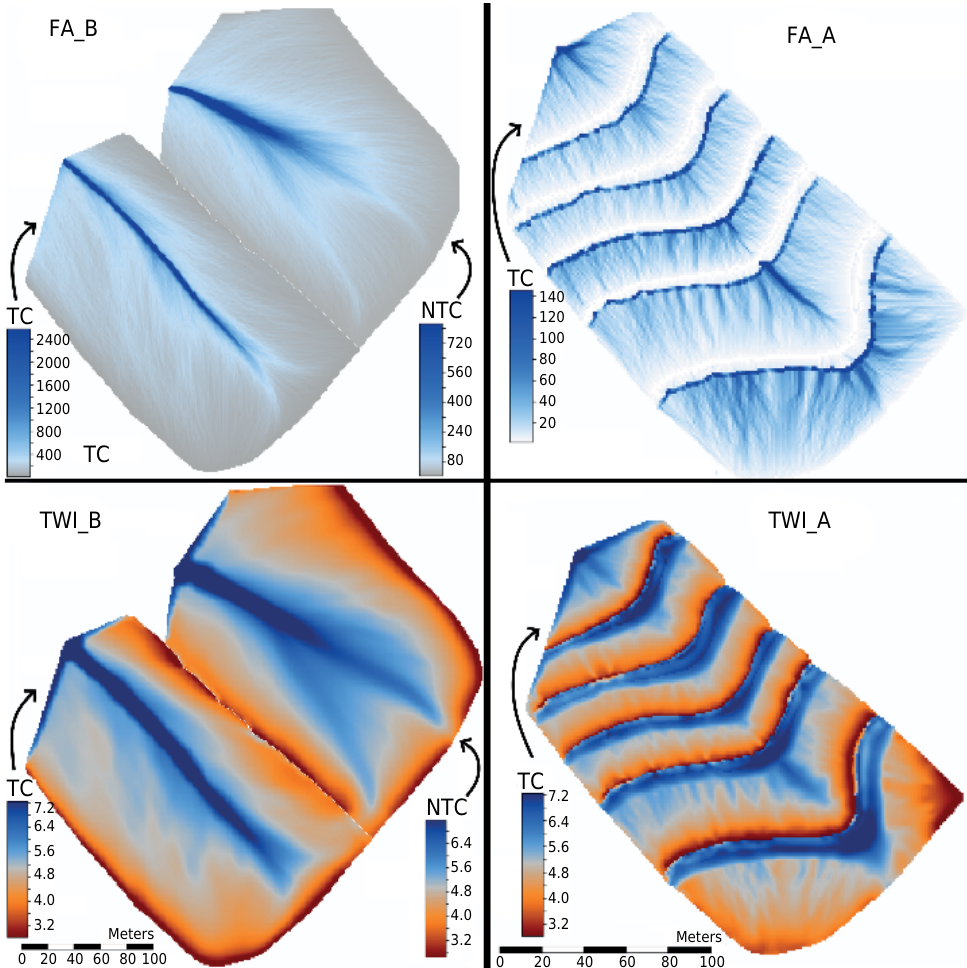
Figure 7. Flow accumulation area (FA) and topographic wetness index (TWI) for the non-terraced catchment (NTC) and terraced catchment (TC) before (B) and after (A) the construction of the terraces in the Rio Grande do Sul State, southern